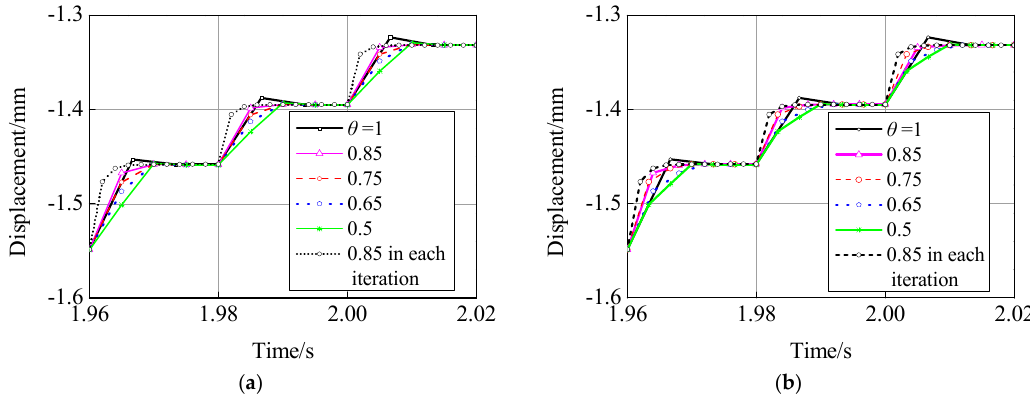
Figure 6. Iterative vertical displacement on the top of column. ( a ) Reduction factor used in the first iteration; ( b ) Reduction factor used in the first two iterations